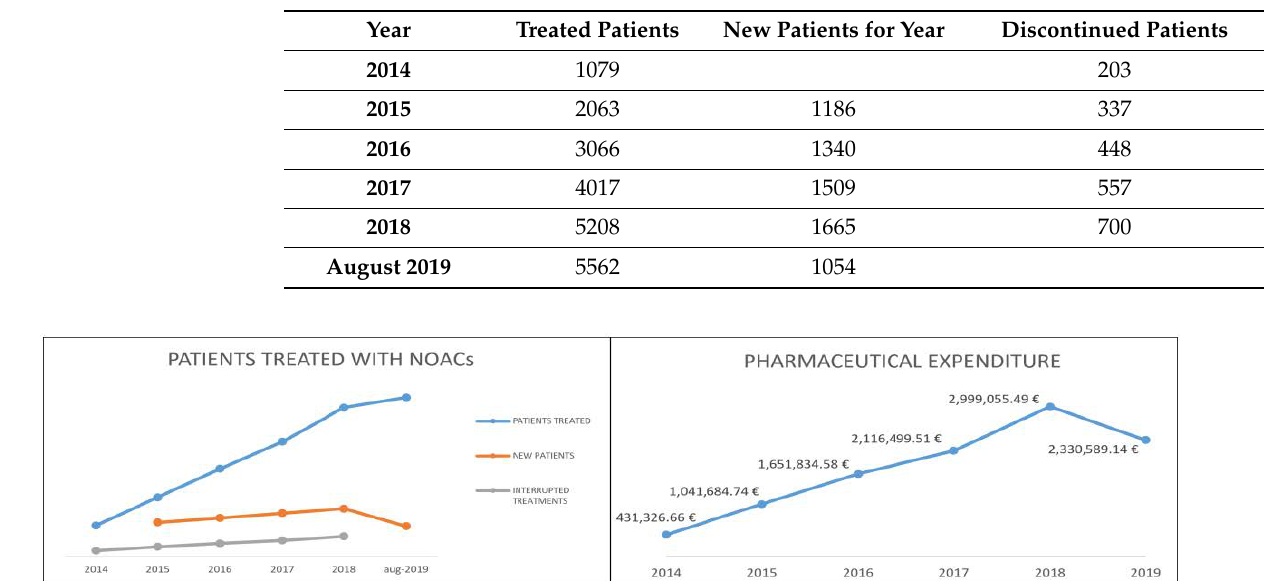
Table 3. Summary of patients treated in LHA BT in the period January 2014–August 2019.